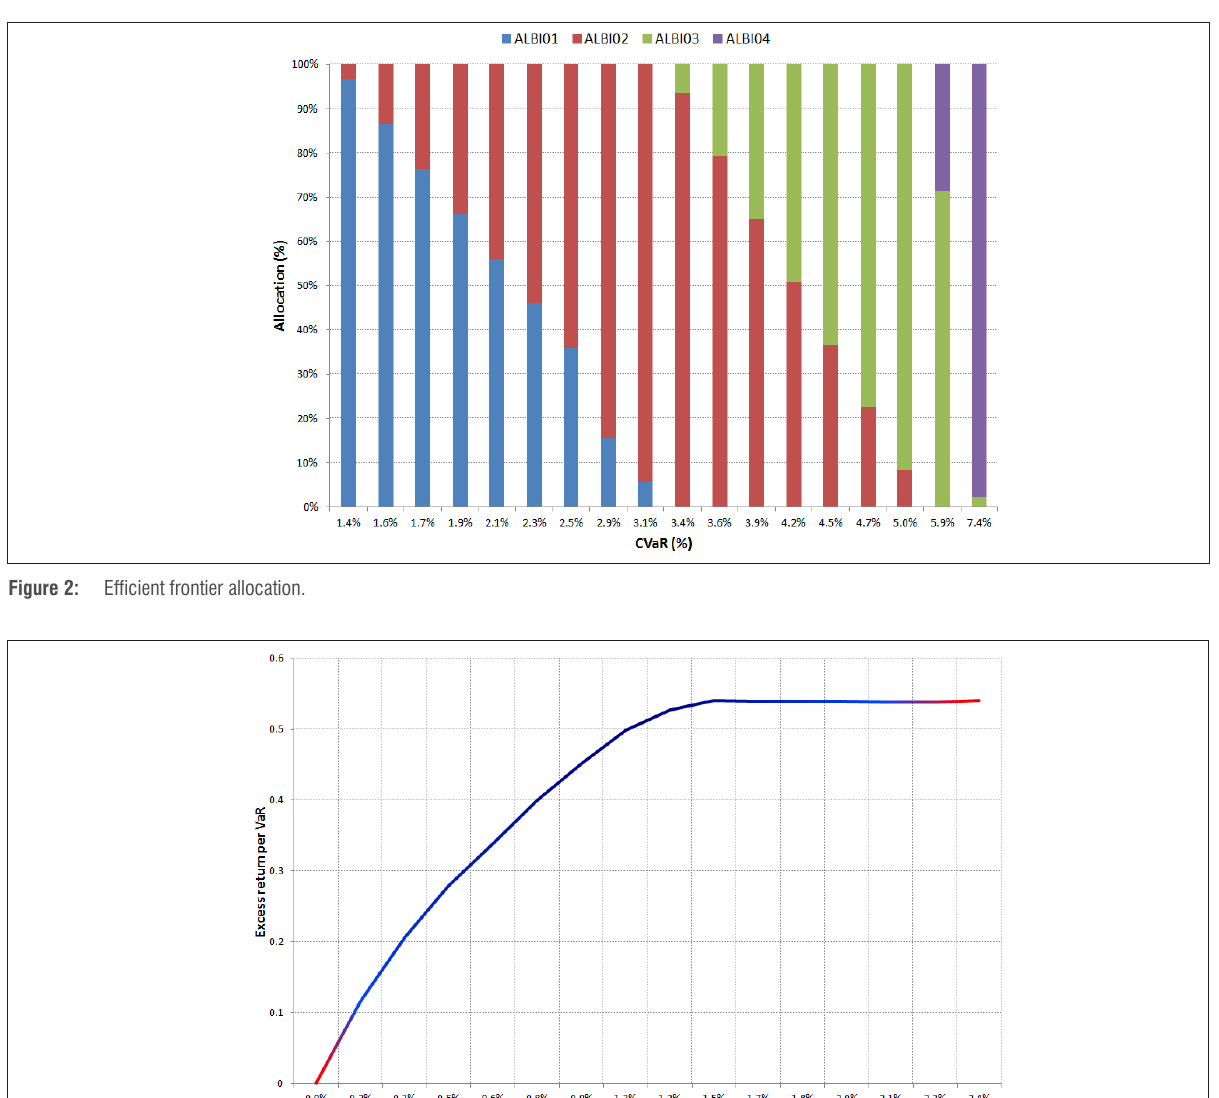
Figure 1: Efficient frontier.